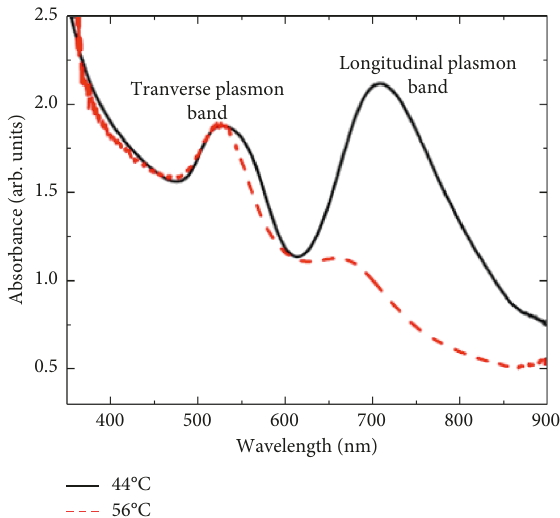
Figure 2: UV-Vis spectrum of AuNRs at different preparation temperatures [61].